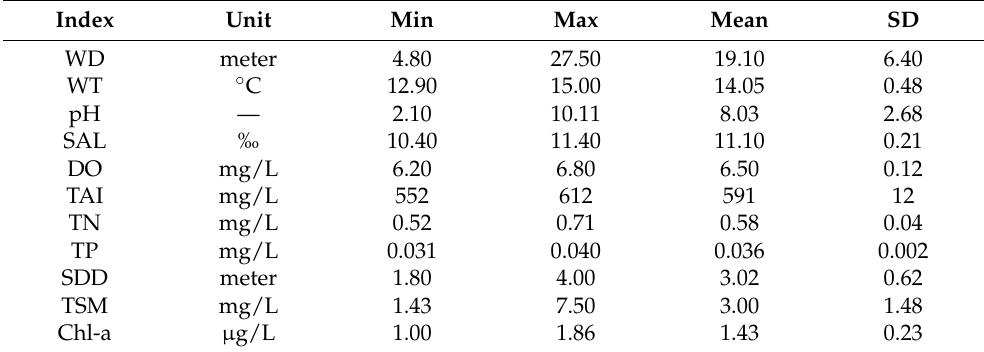
Table 2. The physical and chemical concentrations of Lake Qinghai in September 2019. WD, WT, pH, SAL, DO, TAI, TN, TP, SDD, TSM, and Chl-a, represent water depth, water temperature, potential of hydrogen, salinity, dissolved oxygen, total alkalinity, total nitrogen, total phosphorus, Secchi disc depth, total suspended matter and chlorophyll-a. Min., Max., Mean and SD represent the minimum, maximum, mean value, and standard